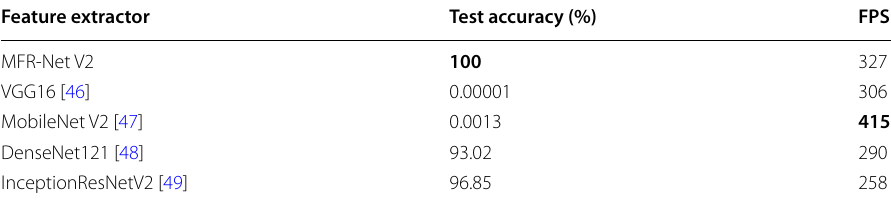
Table 6 Various feature extractor test results Feature